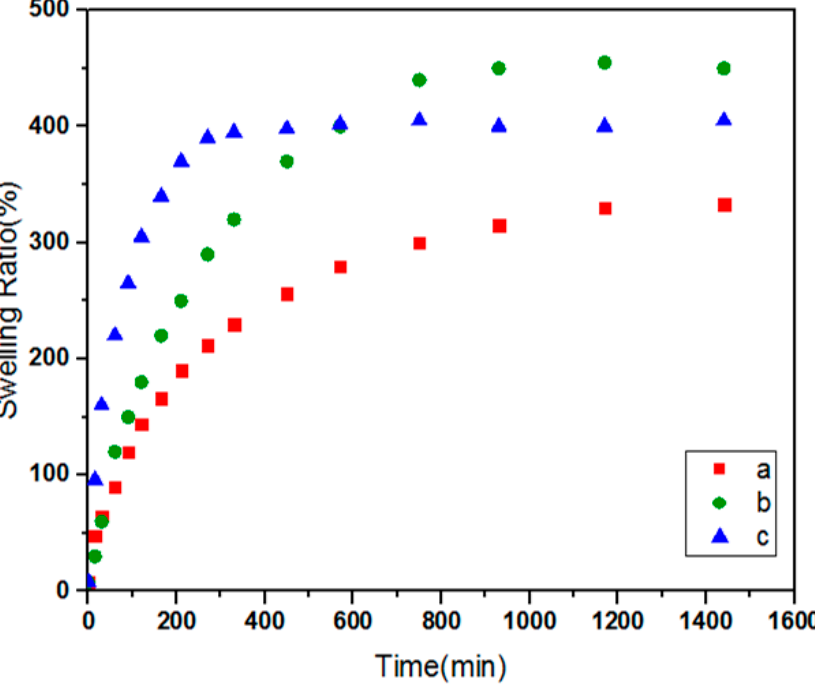
Figure 9. Swelling behavior of the copolymeric hydrogel ( a ), the core-shell microgel ( b ), and the nanocomposite microgel ( c ).